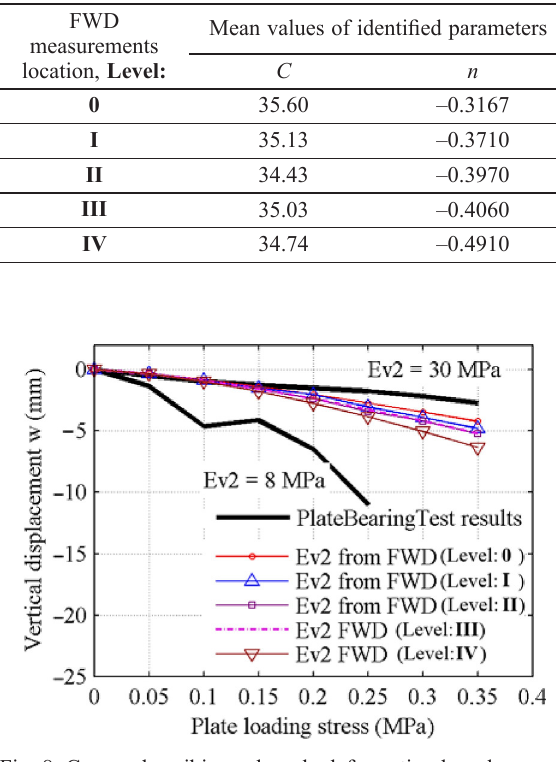
Fig. 8. Curves describing subgrade deformation based on model with stress sensitive layers moduli and extreme deformation curves determined by in-situ plate bearing testing across the entire length of test